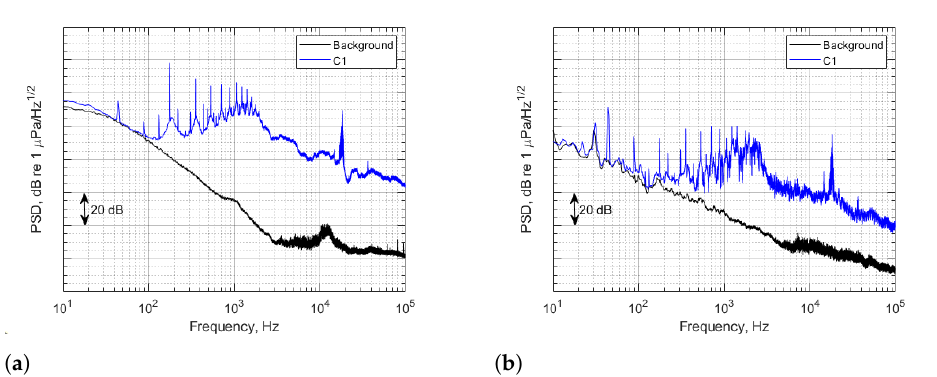
Figure 9. Comparison between the measured signal and background noise: ( a ) hull sensor and ( b ) sensor at the tunnel bottom.